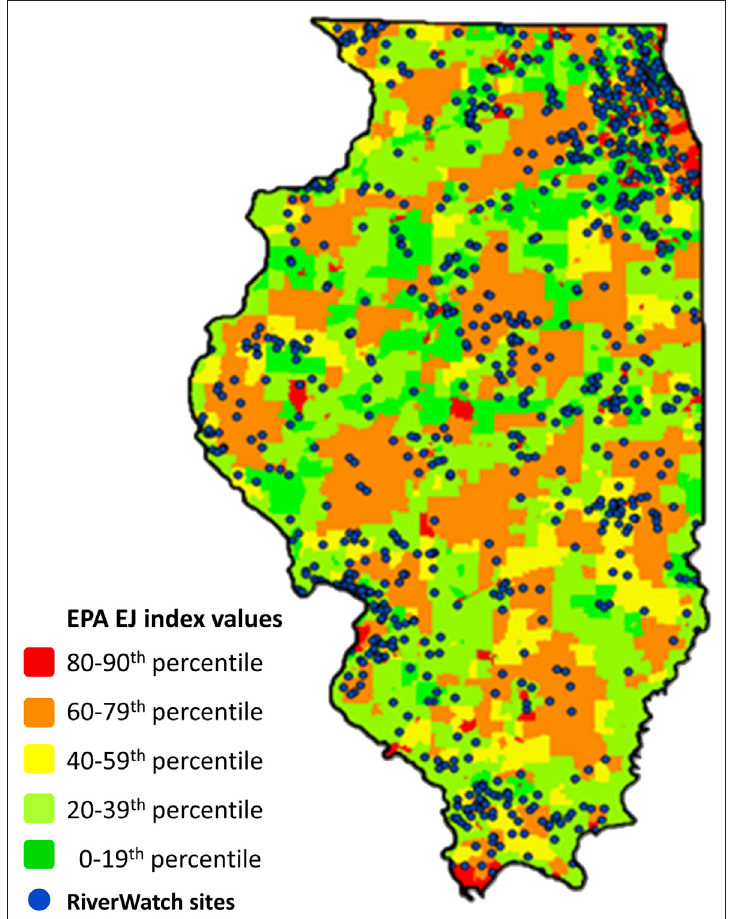
Figure 3: Location of RiverWatch monitoring sites overlaid on percentile rankings from United States Environmental Protection Agency (US EPA) wastewater discharge environmental justice (EJ) index values, which take into account both sociodemographic factors and environmental